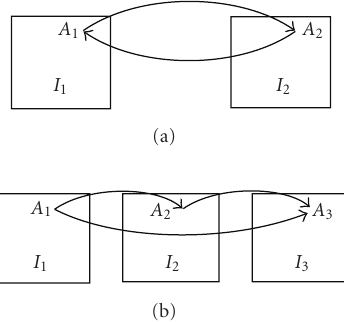
Figure 1: If two points ( A 1 and A 2 ) in two images ( I 1 and I 2 ) correspond, as sketched in (a), then the registration algorithm should associate the two points regardless of the order of images. This is the symmetry property. Let I 1 , I 2 , and I 3 represent images of the same deforming object taken at three-time points, and let A 1 , A 2 , and A 3 represent the location of the same physical point in the three images, as sketched in (b). If the registration algorithm, when applied to images I 1 and I 2 , associates points A 1 and A 2 , and, when applied to images I 2 and I 3 , associates points A 2 and A 3 , then it should, when applied to images I 1 and I 3 , associate points A 1 and A 3 . This is the transitivity